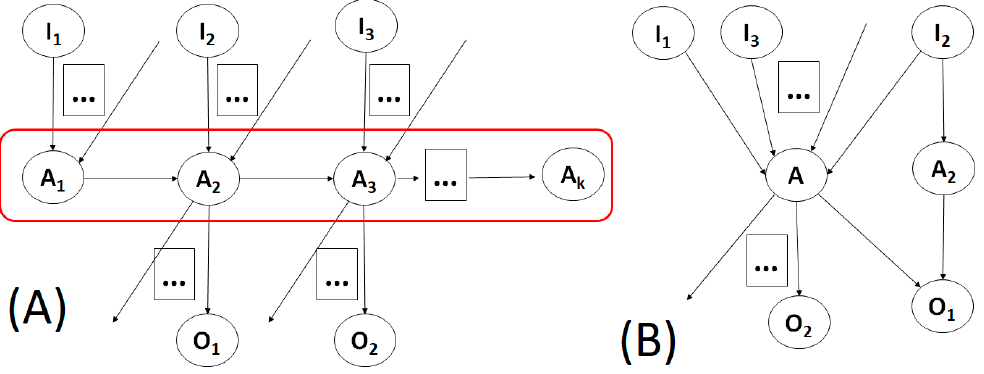
Figure 5. ( A ) Example of a graph with intersecting paths, where the red box marks the path p = <A 1 → A 2 → . . . → A k > , which will be substituted with a single node A , as illustrated in ( B ), where the resulting model shown the re-addressing of all the arcs entering/exiting any node in P as arcs entering/exiting A and preserving the “relevant” intersecting path . . . I 2 → A 2 → O 1 . . .